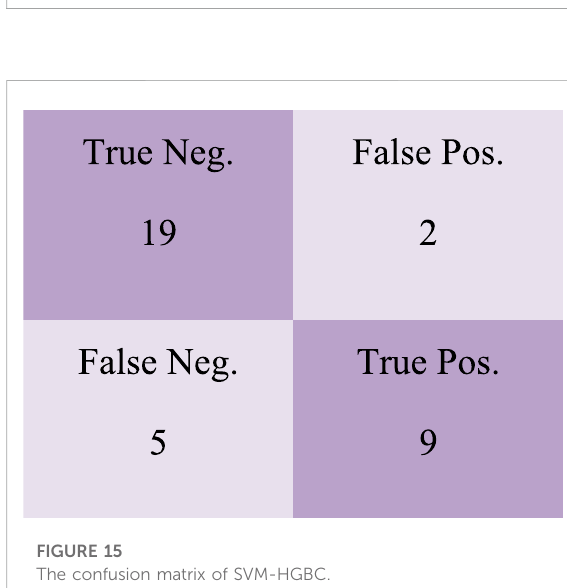
FIGURE 15 The confusion matrix of